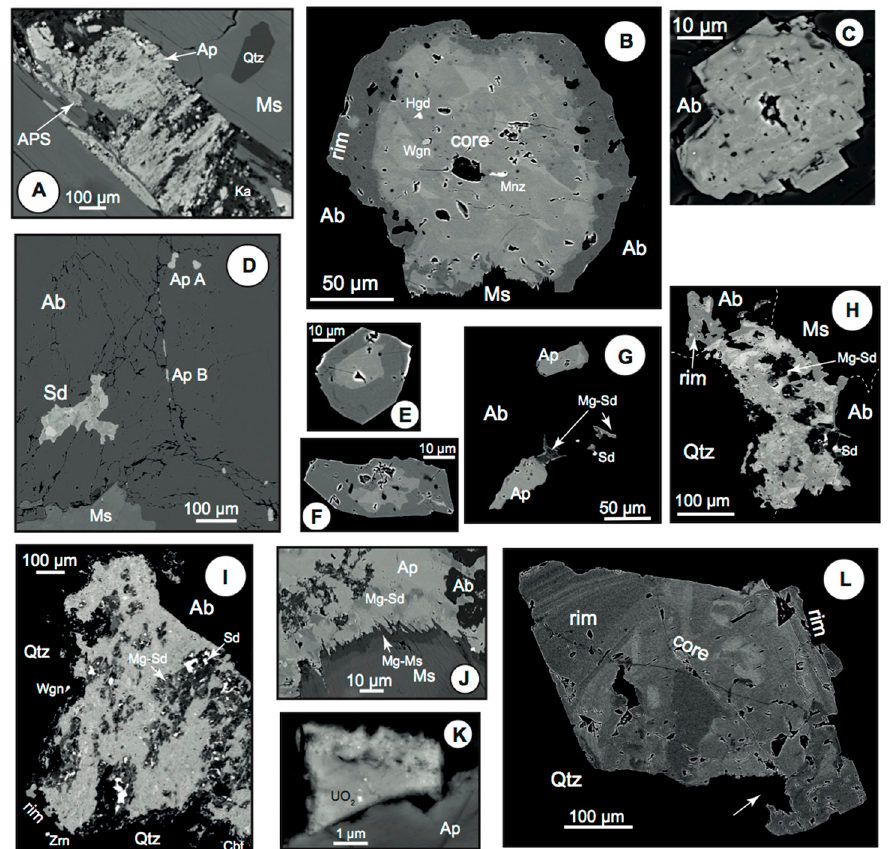
Figure 7. SEM-BSE images of apatite in the G2, G3, and G4 granites (BSE images). Ab albite, Ap apatite, APS alumina-phosphate-sulfate, Cbt columbite-tantalite, Ms muscovite, Hgd hagendorfite, Ka kaolinite, Mnz monazite, Qtz quartz, Sd siderite, Wgn wagnerite, Zrn zircon. ( A ) In G2, a transformation of microfissural apatite into an APS-kaolinite assemblage (detail of E in Figure 6). ( B ) Zoned apatite in G2 granite (sample PAN-16-8), with a patchy zoned core and a rim. Note the various phosphate micro-inclusions in the core, and the ragged contact with muscovite. ( C ) Small euhedral Sr-APS crystal included in albite (G2 granite, sample PAN-16-8). The bright internal zones and overgrowth correspond to an increase in the S content. ( D ) Siderite-apatite association in albite from the G3 leuco-microgranite (sample PAN-16-9). Two types of apatite are present: small zoned euhedral crystals (Ap A), like in E or F , and small homogenous elongated prisms, with external rims in Ap A, apparently following a microcrack in the hosting albite (Ap B). Siderite is zoned, according to variable Mg contents, with the brightest areas being pure Fe-end member. ( E , F ) Examples of zoned apatite included in albite (G2 granite, sample PAN-16-8). ( G ) Another example of an apatite-siderite association in albite (G2 granite, sample PAN-16-8). ( H , I ) Two zoned apatite crystals in the leuco-microgranite G3 (sample PAN-16-9), with a patchy core and a discontinuous homogenous rim. Note the strong corrosion by internal siderite (Mg-Sd and pure siderite), and the contrast in the boundary habit depending on the host, the boundary being ragged at the quartz contact, with a halo of minute apatite specks, and quite regular at the albite contact. ( J ) In G3, a denticulate contact between apatite and the Mg-rich fringe of a muscovite crystal (sample PAN-16-9). ( K ) In the greisenised G4 granite, overgrowth on apatite of an APS (goyazite-florencite solid solution), with uraninite nano-inclusions (sample PNQ-19a). ( L ) A large crystal of apatite in the greisenised G4 granite (sample PNQ-19a), with a patchy zoned core and a rim displaying a conspicuous OZ. Note the locally contorted boundary (arrow), similar to some apatite habit in greisenised granite G1b (Figure 14). The small zircon crystals (1–5 µm, up to 10–20 µm), included in muscovite or in quartz, are homogenous, or well zoned, with a Hf-rich core (up to 5.3 wt% Hf, Hf# 0.06) and a rim with a lower Hf content (3.2 wt% Hf, Hf# 0.04), but richer in U (up to 2.6 wt% U in the rim, versus 0.6 wt% U in the core).